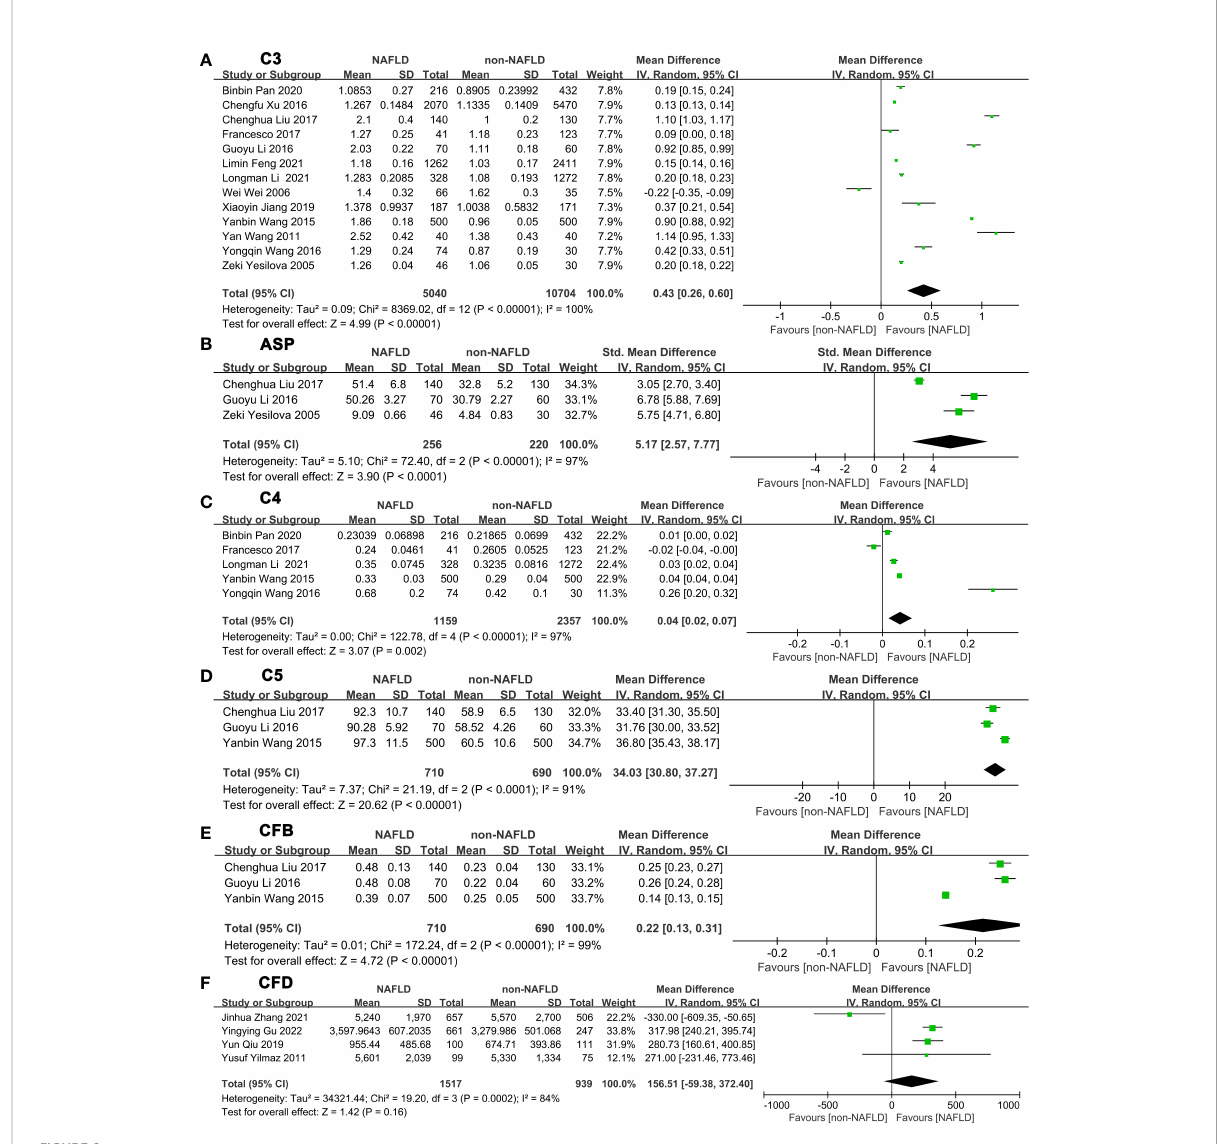
FIGURE 2 Forest plots of the deviation of complement components between NAFLD and non-NAFLD. The forest plots show the MD value and 95% CI of the NAFLD group compared with the non-NAFLD group. Due to the large heterogeneity, a random effect model was used to analyze the included studies. (A) A random effect model was used to analyze the deviation of C3 between NAFLD and non-NAFLD. (B) A random effect model was used to analyze the deviation of ASP between NAFLD and non-NAFLD. (C) A random effect model was used to analyze the deviation of C4 between NAFLD and non-NAFLD. (D) A random effect model was used to analyze the deviation of C5 between NAFLD and non-NAFLD. (E) A random effect model was used to analyze the deviation of CFB between NAFLD and non-NAFLD. (F) A random effect model was used to analyze the deviation of CFD between NAFLD and non-NAFLD. Abbreviations: ASP, acylation stimulating protein; C3, complement component 3; C4, complement component 4; C5, complement component 5; CFB, complement factor B; CFD, complement factor D; CI, con fi dence interval; IV, Inverse Variance; NAFLD, nonalcoholic fatty liver disease; SD, standard